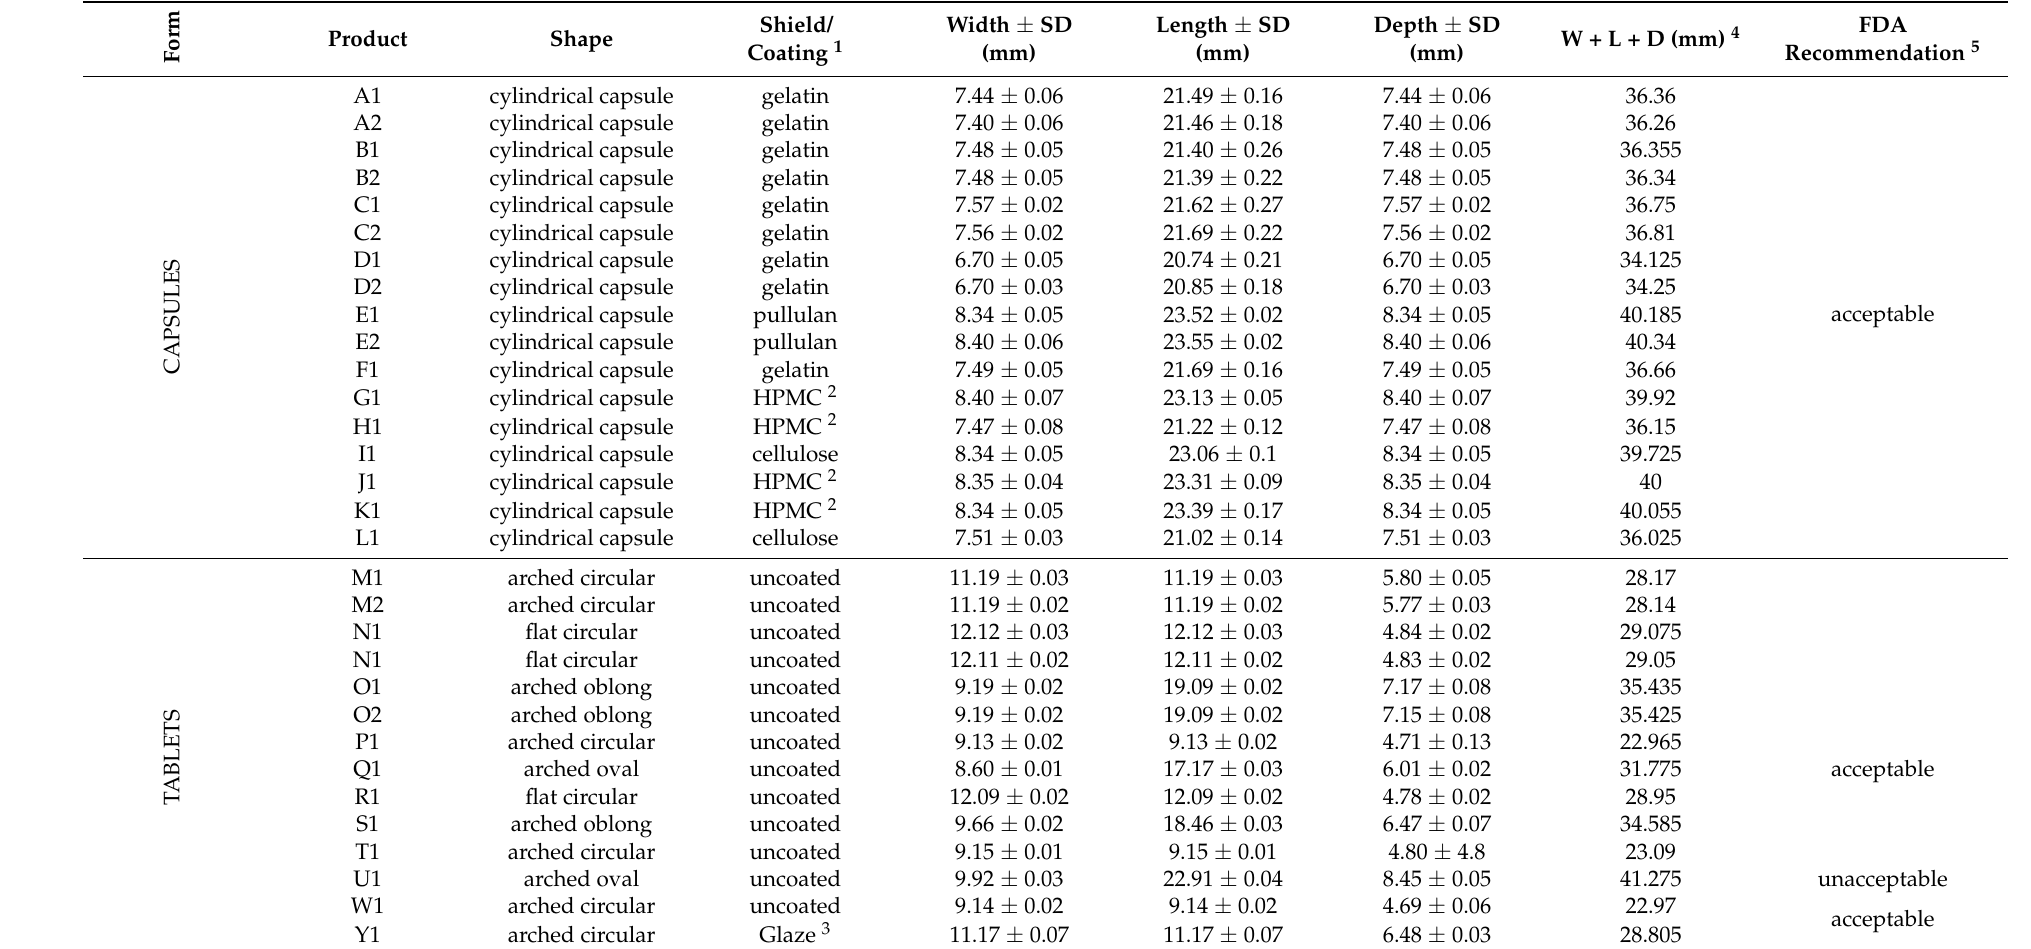
Table 3. Analysis of shape and dimensions of